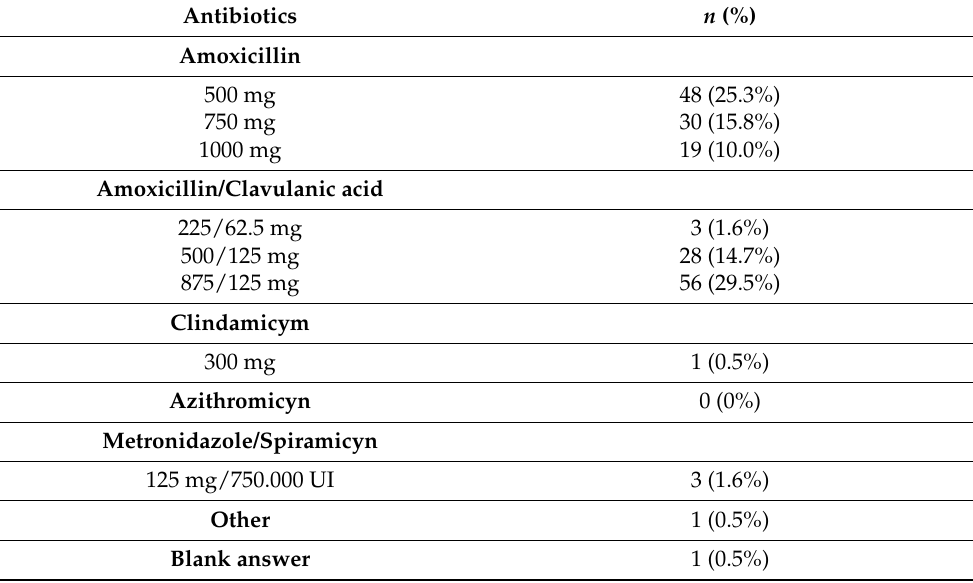
Table 2. Antibiotic preference in patients with no medical